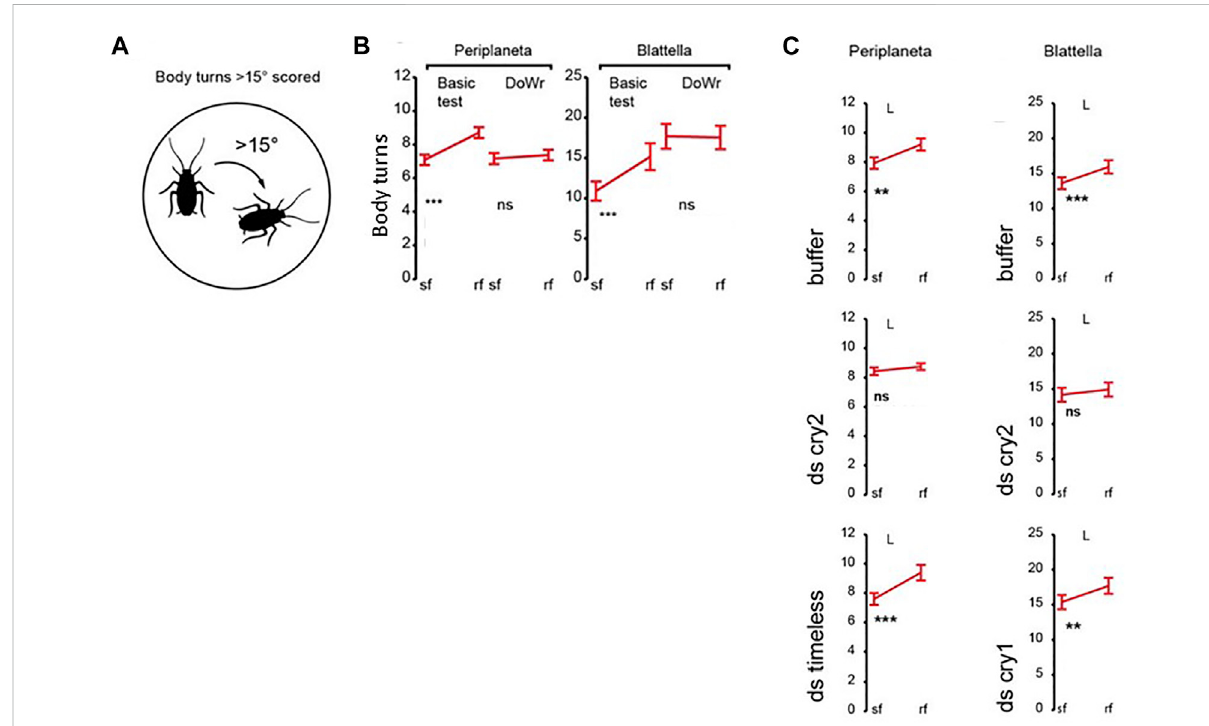
FIGURE 5 Genetic analysis of magnetosensitivity in cockroaches (Bazalova et al., 2016). (A) Diagrammatic representation of the body turn phenotype in response to a rotating MF. (B) Body turns in response to a MF (~45 μ T, 18 μ T horizontal component) for Periplaneta americana and Blattella germanica . Sf, steady fi eld, rf rotating fi eld. Basic test — MF exposure, DoWr-sham double wrapped coils. Under a MF (Basic) a signi fi cant increase in turningisobservedinarotating fi eld(rf)forbothspecies.Y-axisrepresentsbodyturns > 15 o. (C) .Transientdoublestranded(ds)RNAiknockdown of Pacry2 and BgCry2 but not Bgcry1 nor Patimeless (Patim) eliminates the MF-mediated turning response. For (B,C) ** p < 0.01, *** p < 0.001. Figure redrawn and simpli fi ed from Figures 1 – 3 from Bazalova et al (2016) with